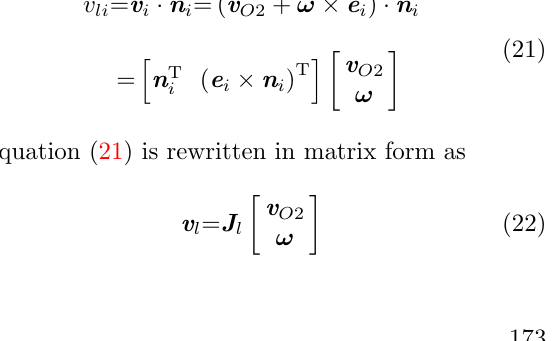
Figure 3: The movement diagram of the MP along z direction, with extreme positions displayed in dashed lines Figure 3 shows the movement range of the MP in the z direction. Extreme positions are achieved when l 3 are reached. minimum or maximum lengths of l 1 and Figure 5: The rotation extreme position of the MP around y Figure 5: The rotational extreme position of the MP around y axis